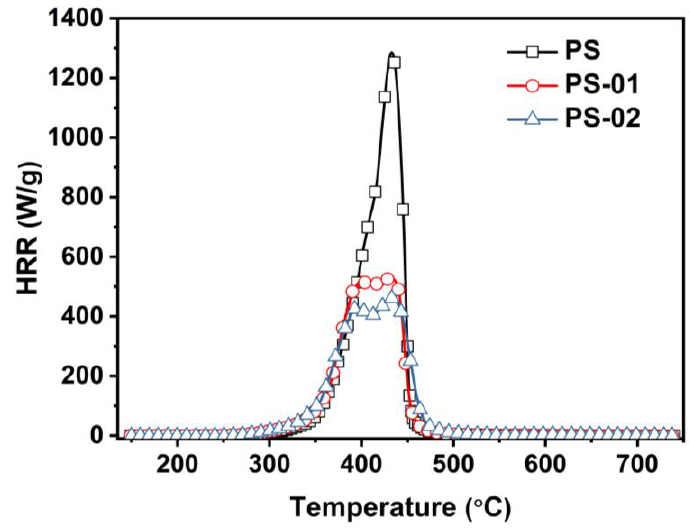
Figure 9. HRR curves of PS, PS-01, and PS-02 in MCC tests. Table 4. Characteristic parameters in MCC